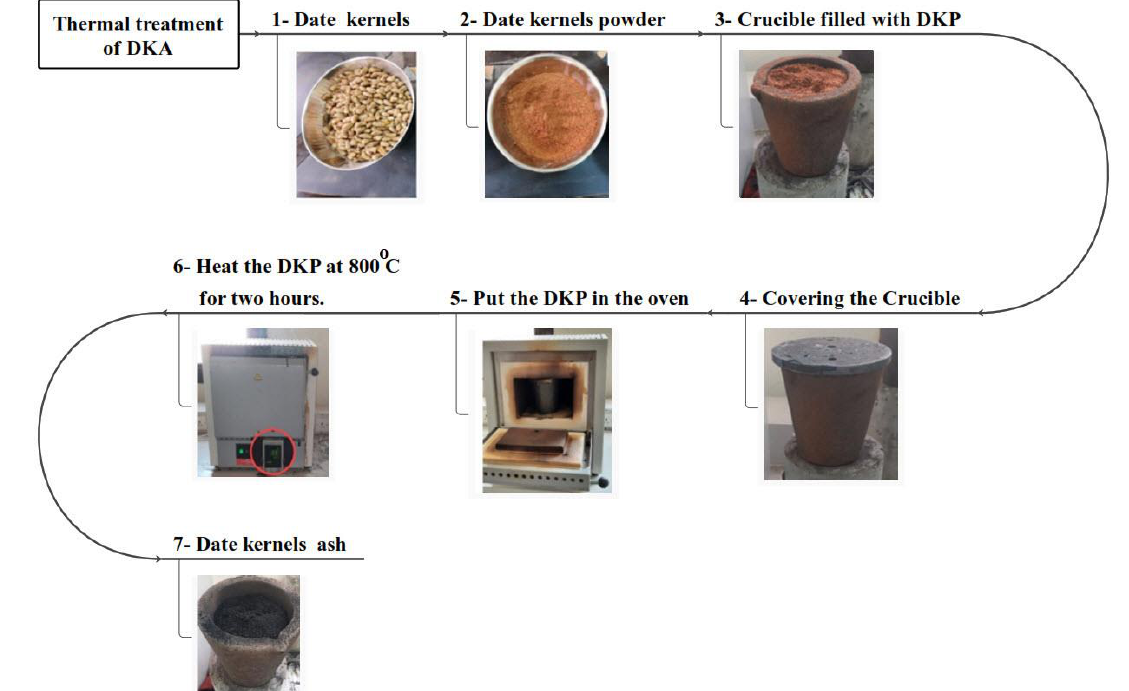
Figure 8. Thermal treatment of DKA.